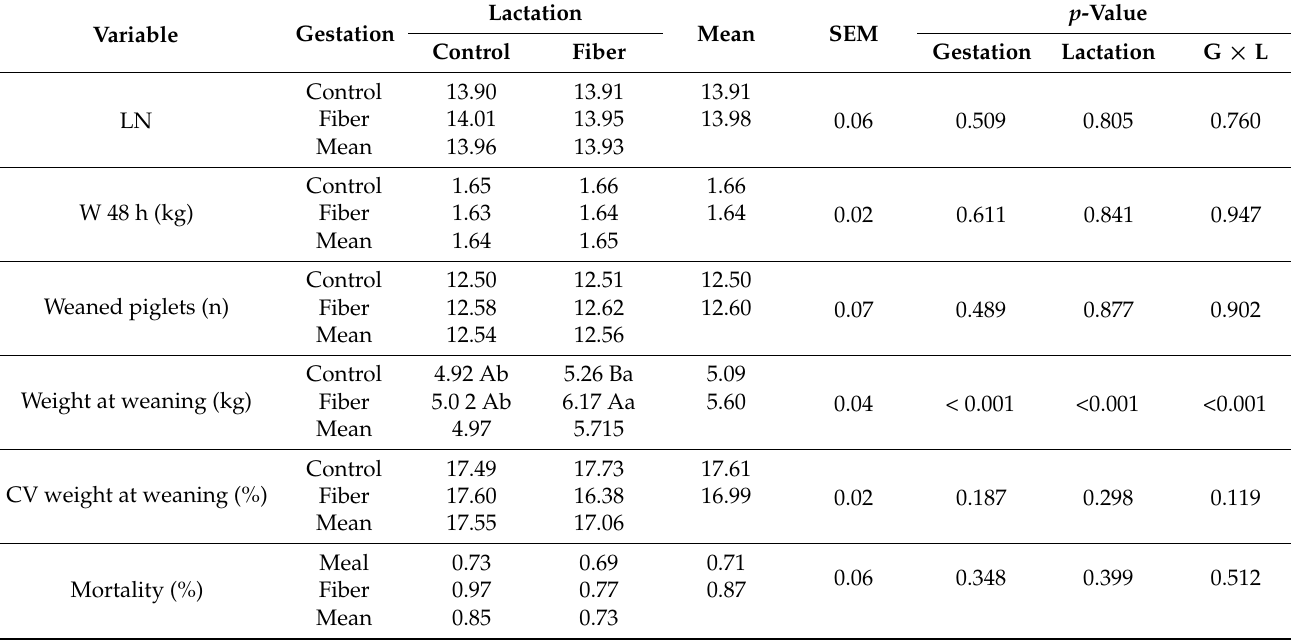
Table 5. Number of piglets per sow after litter standardization (LN), weight of piglets 48 h after birth (W 48 h), number of weaned piglets per sow, weight of piglets at weaning, coefficient of variation of weight at weaning, and mortality rate of piglets from sows supplemented with dietary fiber during gestation and/or